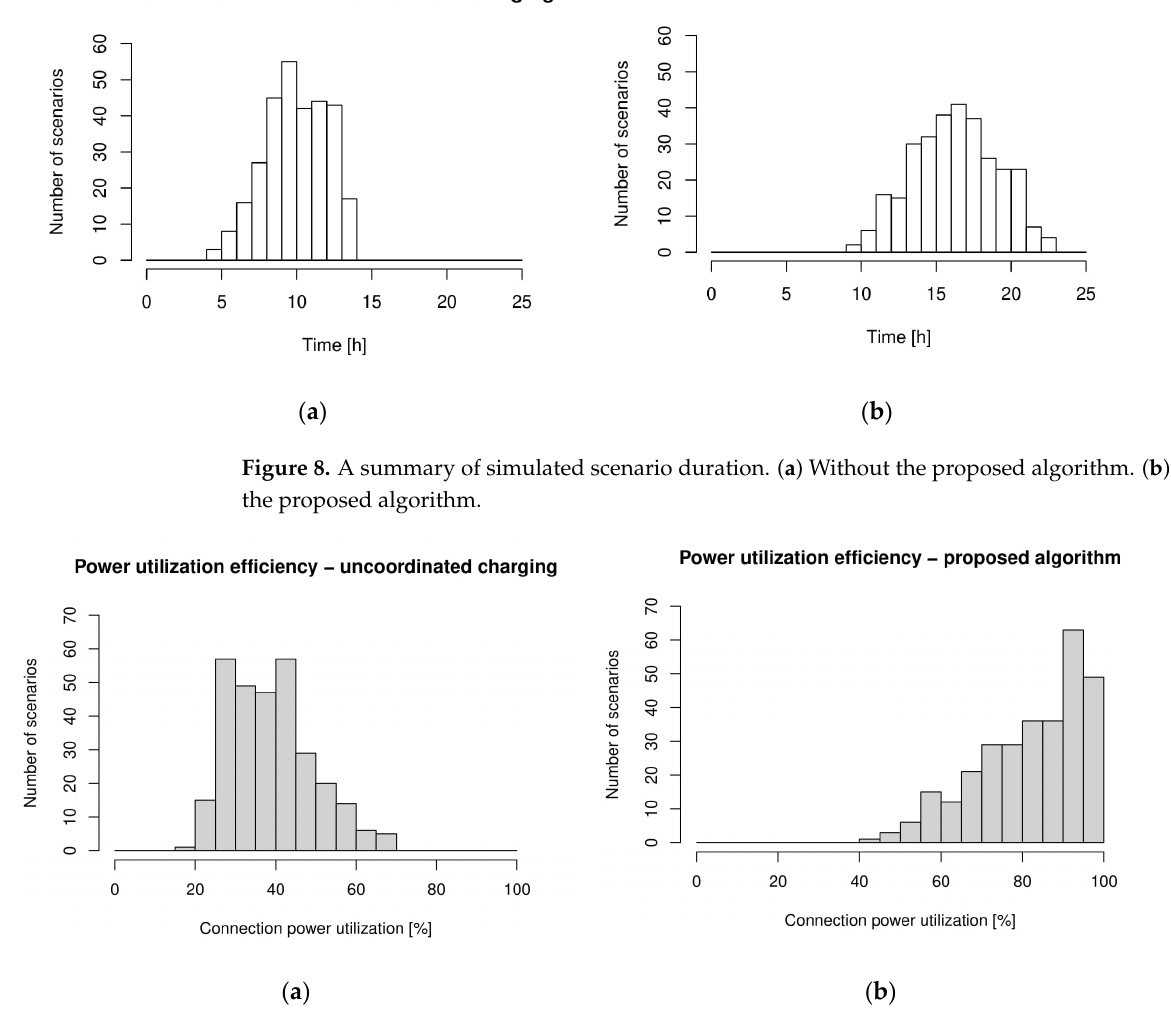
Figure 9. A summary of demanded power utilization efficiency. ( a ) Without the proposed algorithm. ( b ) With the proposed algorithm.